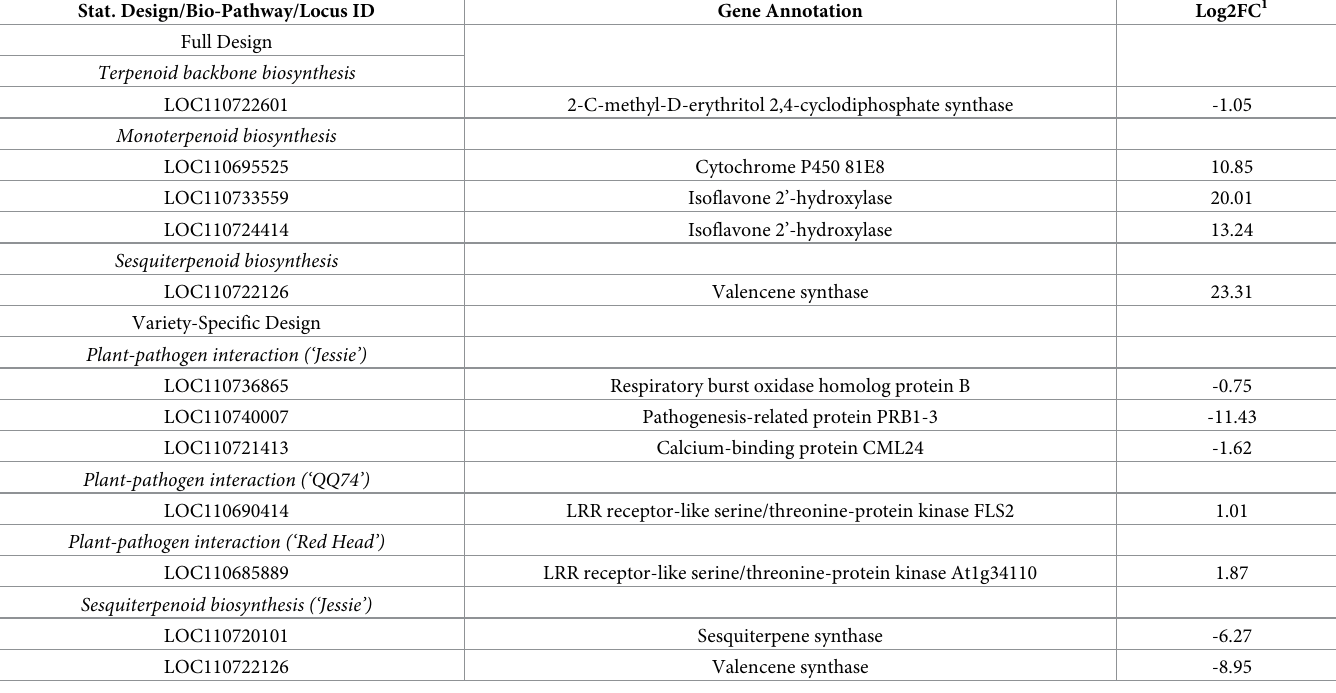
Table 4. Annotation of detected DEGs between cucumber mosaic virus- and mock-inoculated samples involved in terpenoid biosynthesis and plant-pathogen inter- action pathways. Stat. Design/Bio-Pathway/Locus